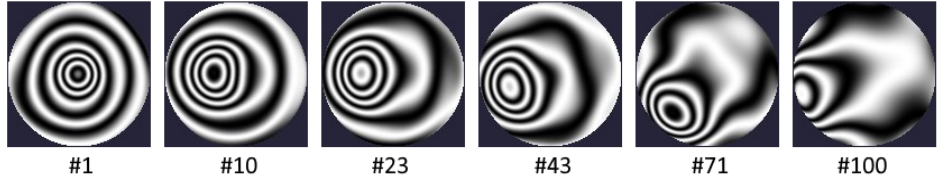
Figure 5. Examples of the response functions of the electrodes under numbers ##1, 10, 23, 43, 71 and 100 in the form of the interferograms.